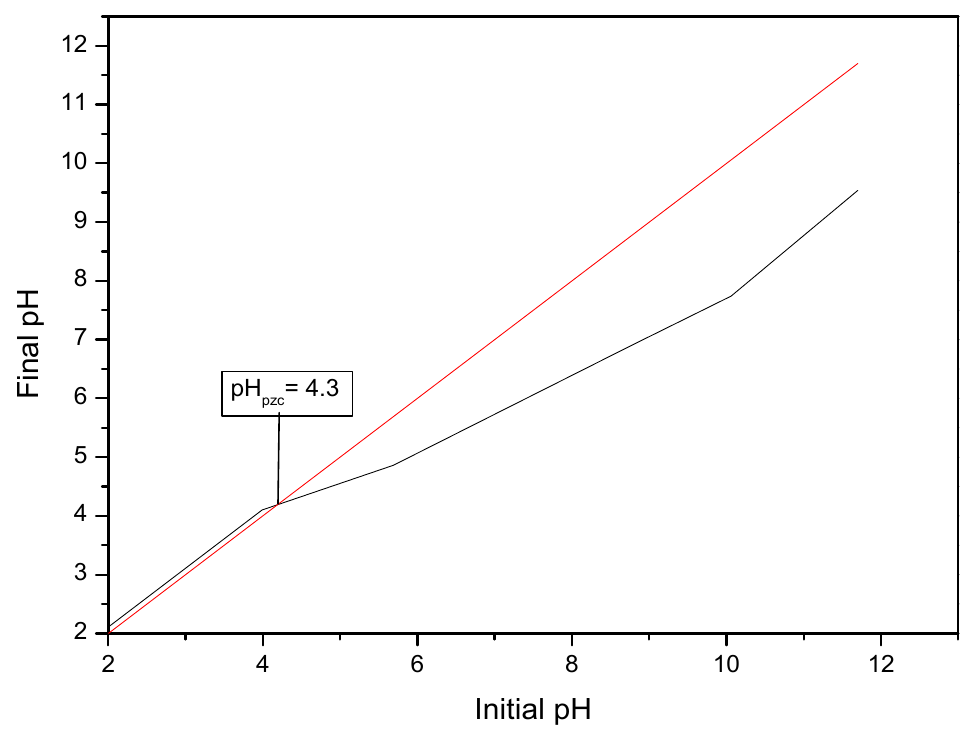
Figure 8. p H value of the point of zero charge (pH pzc ) for raw ALP bio-sorbent. Figure 8. pH value of the point of zero charge (pH